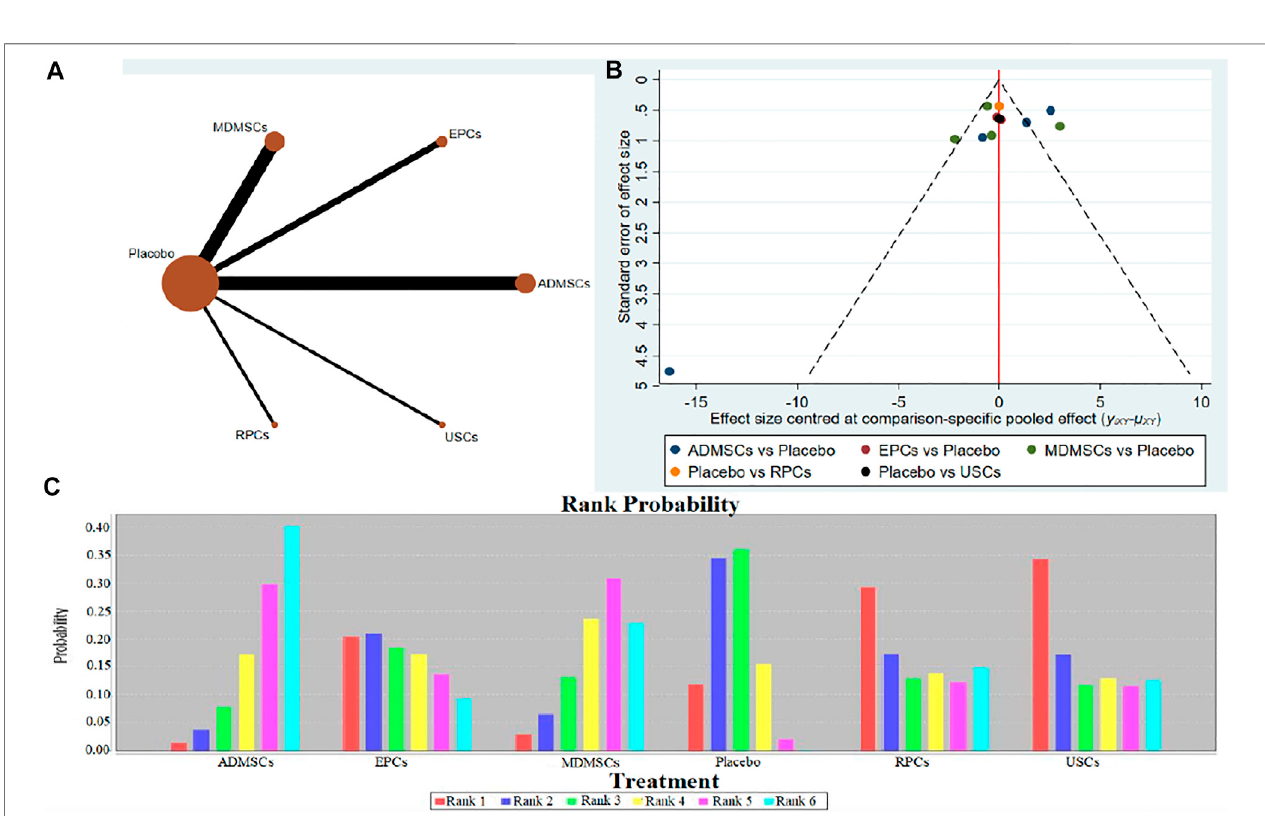
FIGURE5 | Network Meta-analysisofserum creatinine levels at 14 days after administration (A) Evidence network diagram; (B) Thecomparison-correction funnel plot; (C) The ranking results).